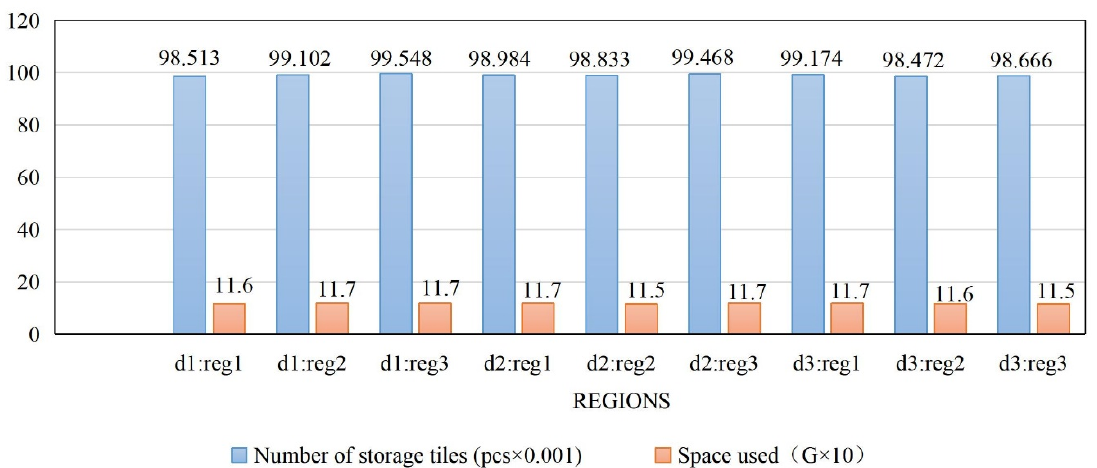
Figure 6. Data distribution in the region